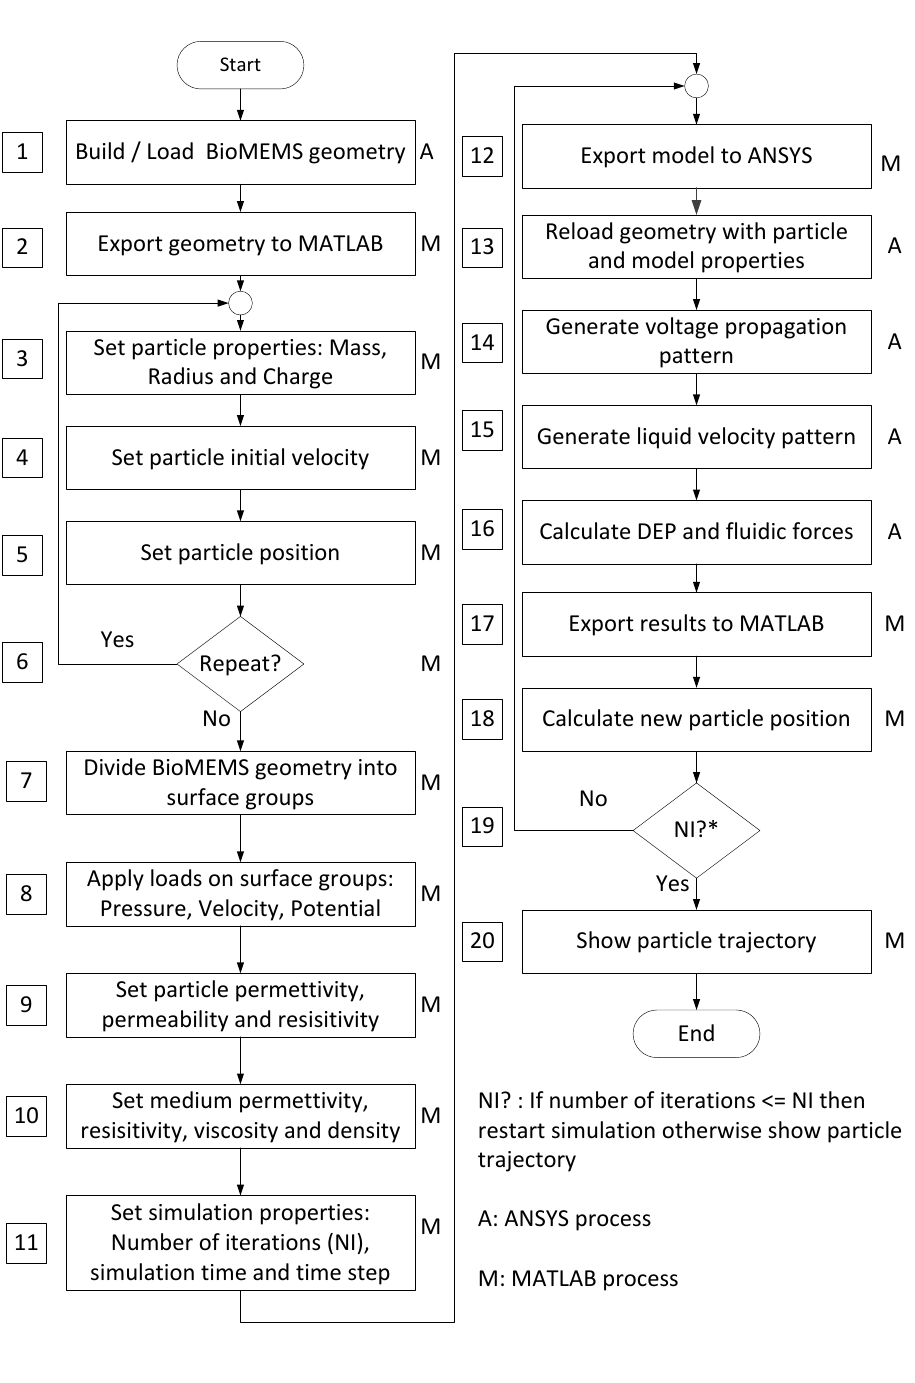
Figure 5. Detailed algorithm of proposed modeling approach for DEP based